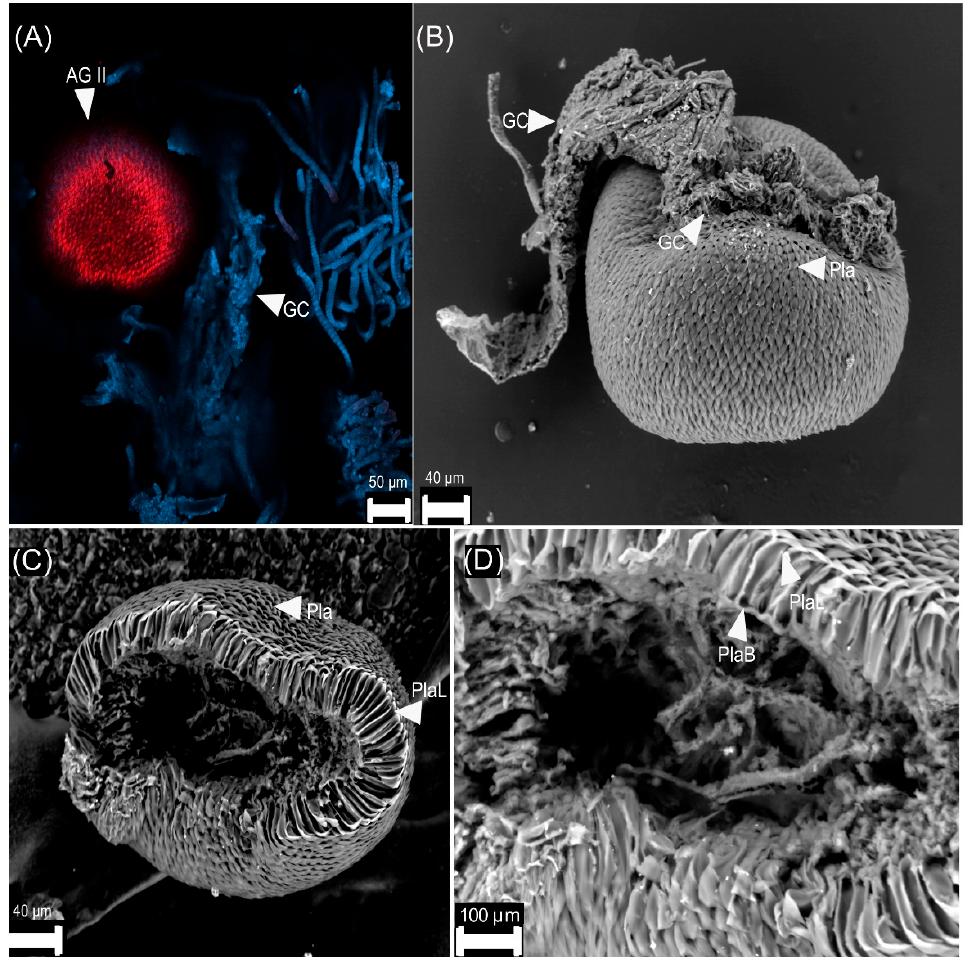
Figure 8. Accessory glands type II of Cyclocephala barrerai female: ( A ) tissue in blue and keratinized structure in red (confocal scanning laser microscopy), ( B ) accessory gland type II with tissue of the genital chamber, ( C ) accessory gland type II (internal view), ( D ) plates in the accessory gland type II (close-up), AG II = accessory glands type II, GC = genital chamber, Pla = plates, PlaL = plates (lateral view), PlaB = plates (ventral view).